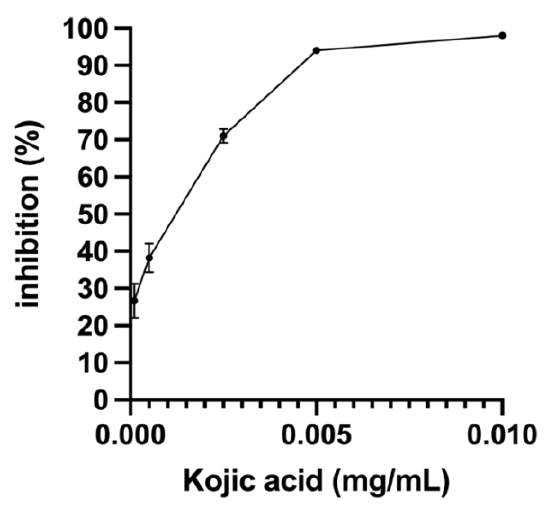
Figure 2. Tyrosinase inhibition curve evaluated for different Kojic acid solutions. Each result represents the mean value of a triplicate analysis and error bars indicate the corresponding standard deviations.